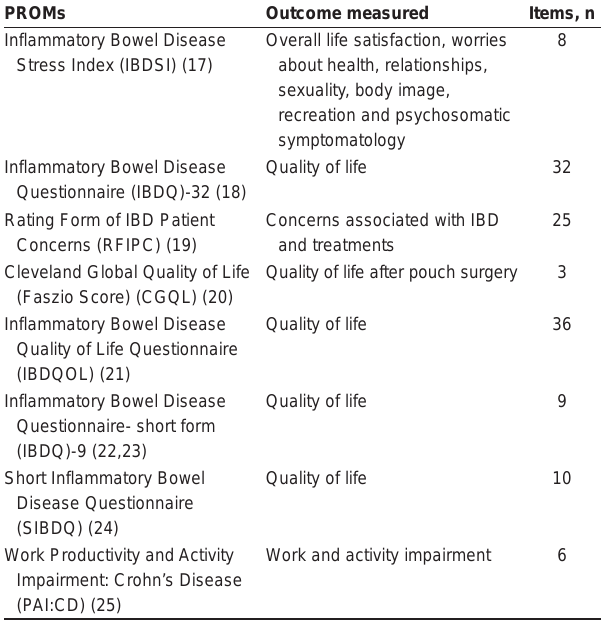
Table 1 Characteristics of inflammatory bowel disease (IbD)- specific patient-reported outcome measures (PROMs) used in adult patients with IbD PROMs Outcome measured Items, n Inflammatory Bowel